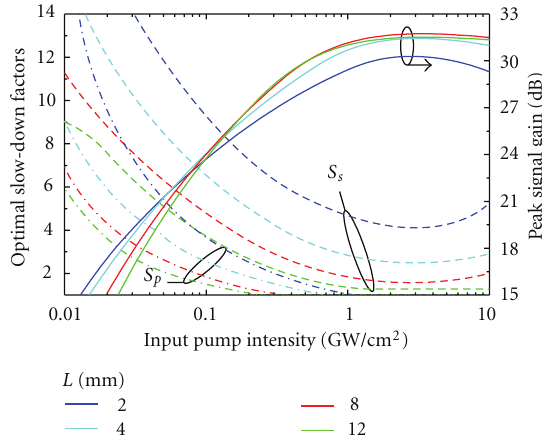
Figure 3: Optimal peak signal gain (solid curves) and slow-down factors, S s (dashed curves) and S p (dash-dotted curves), as functions of input pump intensity in a 2, 4, 8, and 12mm long SRAs. Other parameters are the same as in Figure